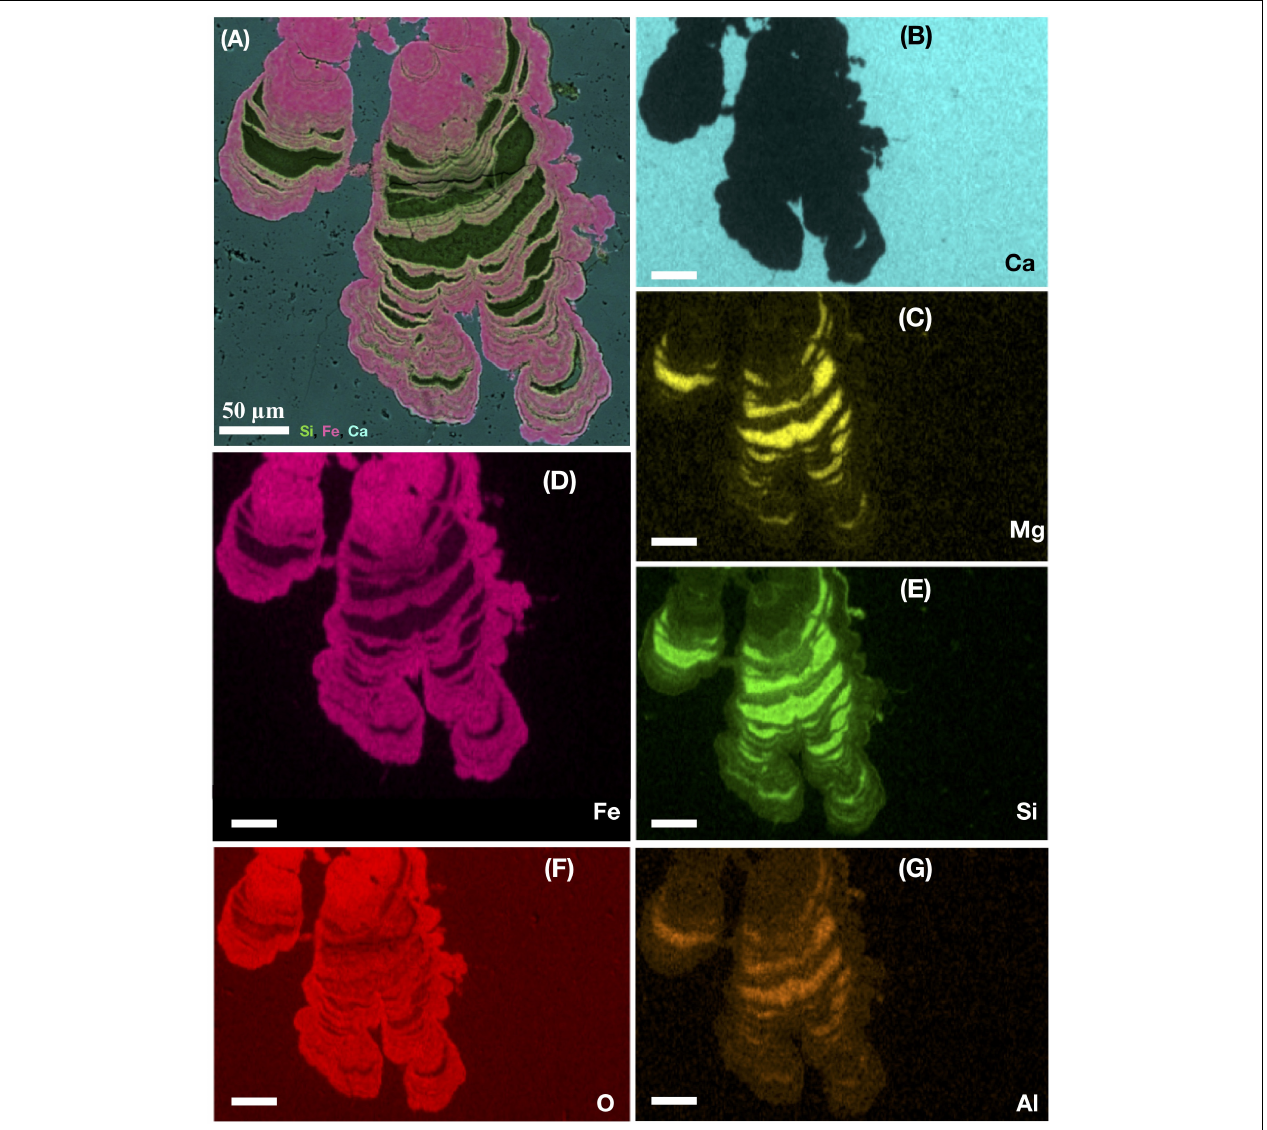
FIGURE 4 | Ocean drilling program sample 197-1204A-7R4, 1 from Detroit Seamount. EDS-elemental map of a microstromatolite shown in cross section. The large image (A) represents a layered map of a laminated subseafloor microstromatolite from the Emperor seamount, Pacific Ocean. The layered map indicates the presence of silica (green), Iron (pink), and Ca (light blue). The following images show (B) the single-distribution of Ca (light blue), (C) Mg (yellow), (D) Fe (pink), (E) Si (green), (F) O (red), and (G) Al (orange) within the stromatolite. All scale bars are 50 µ